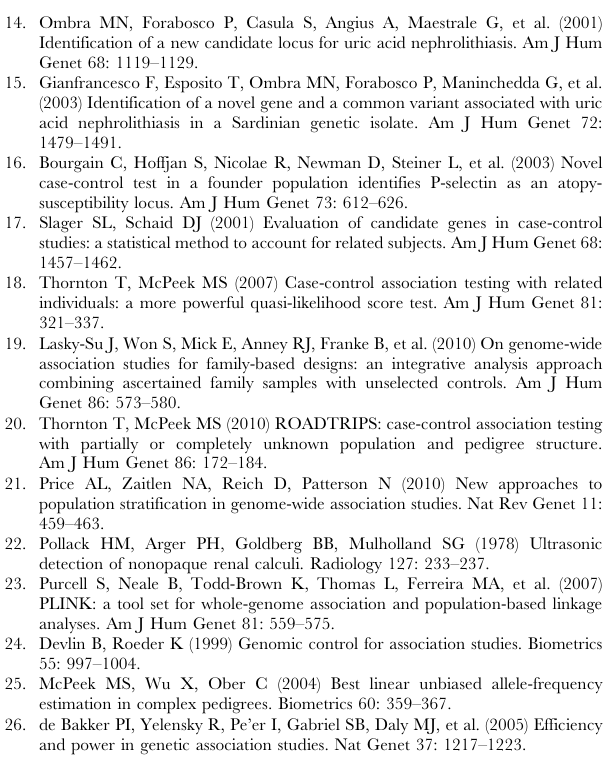
Table S3 Region 6p.